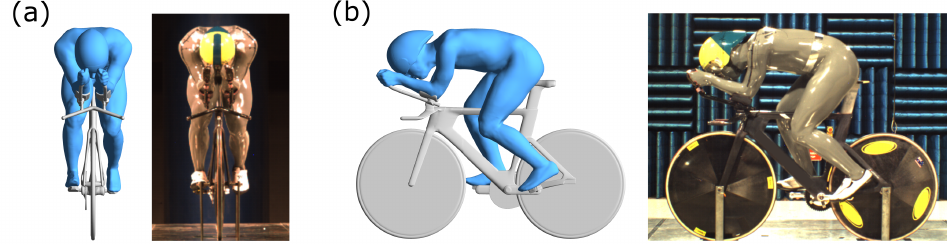
Figure 4. Comparison between the front-on ( a ) and side-on ( b ) CFD and wind-tunnel geometries based on the case